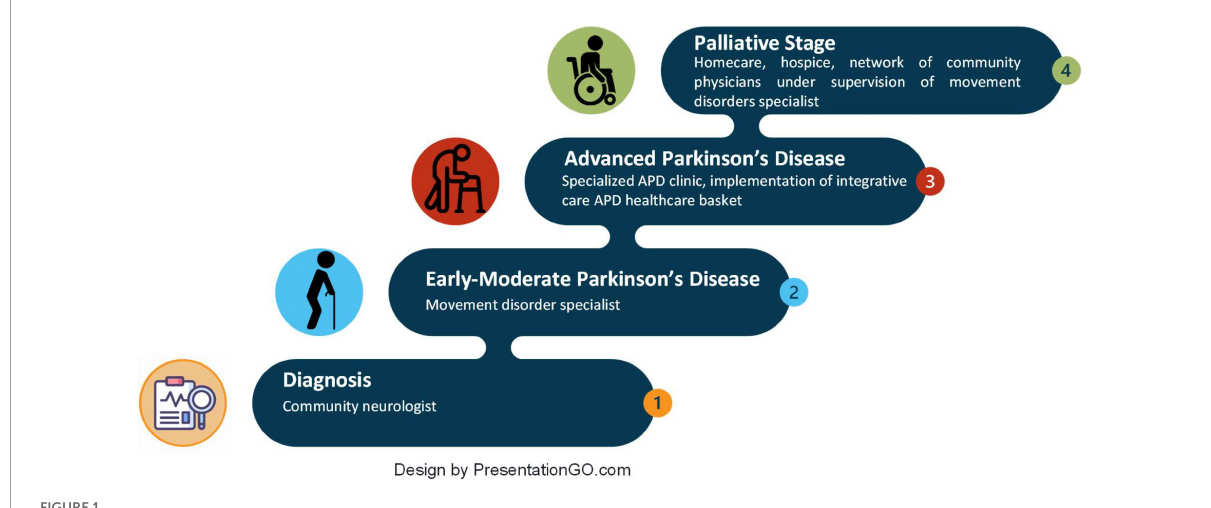
FIGURE1 Parkinson’s disease stages and stage-appropriate healthcare